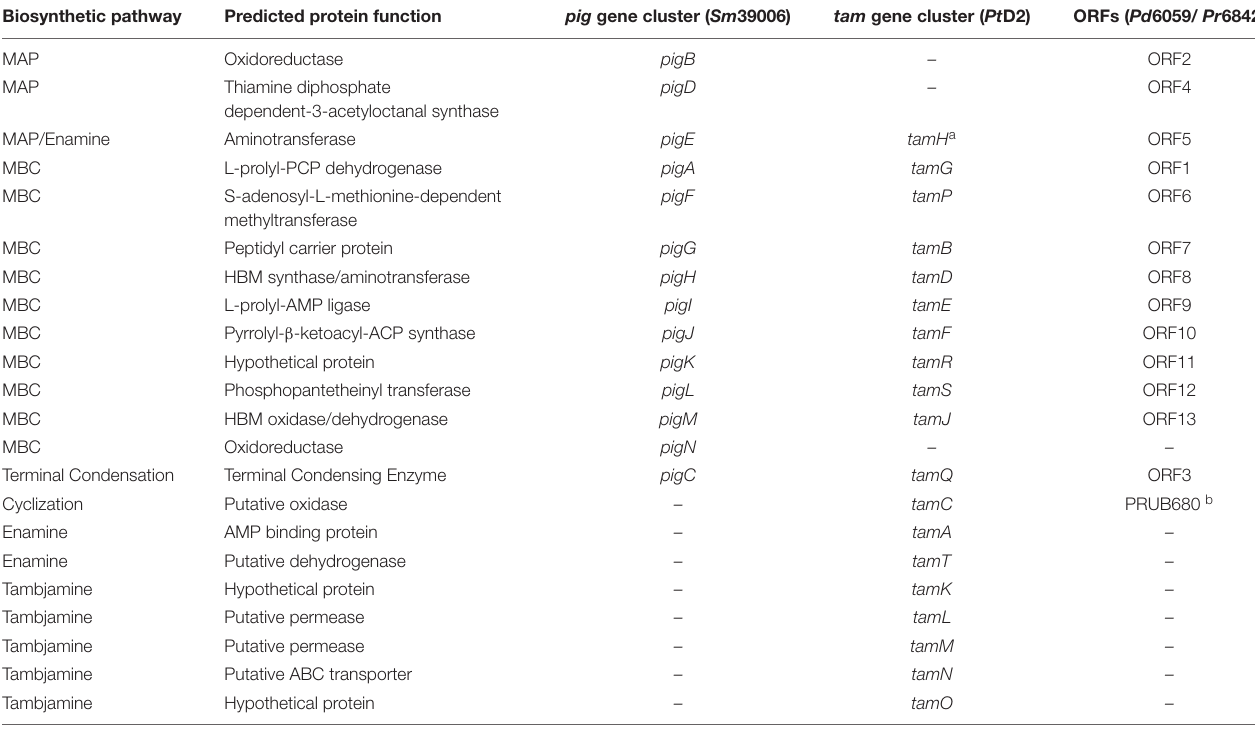
TABLE 1 | Predicted function of genes involved in prodiginine and tambjamine biosynthesis and their homology among Serratia marcescens ( Sm 39006), Pseudoalteromonas rubra ( Pr 6842), Pseudoalteromonas denitrificans ( Pd 6059), and Pseudoalteromonas tunicata ( Pt D2). Biosynthetic